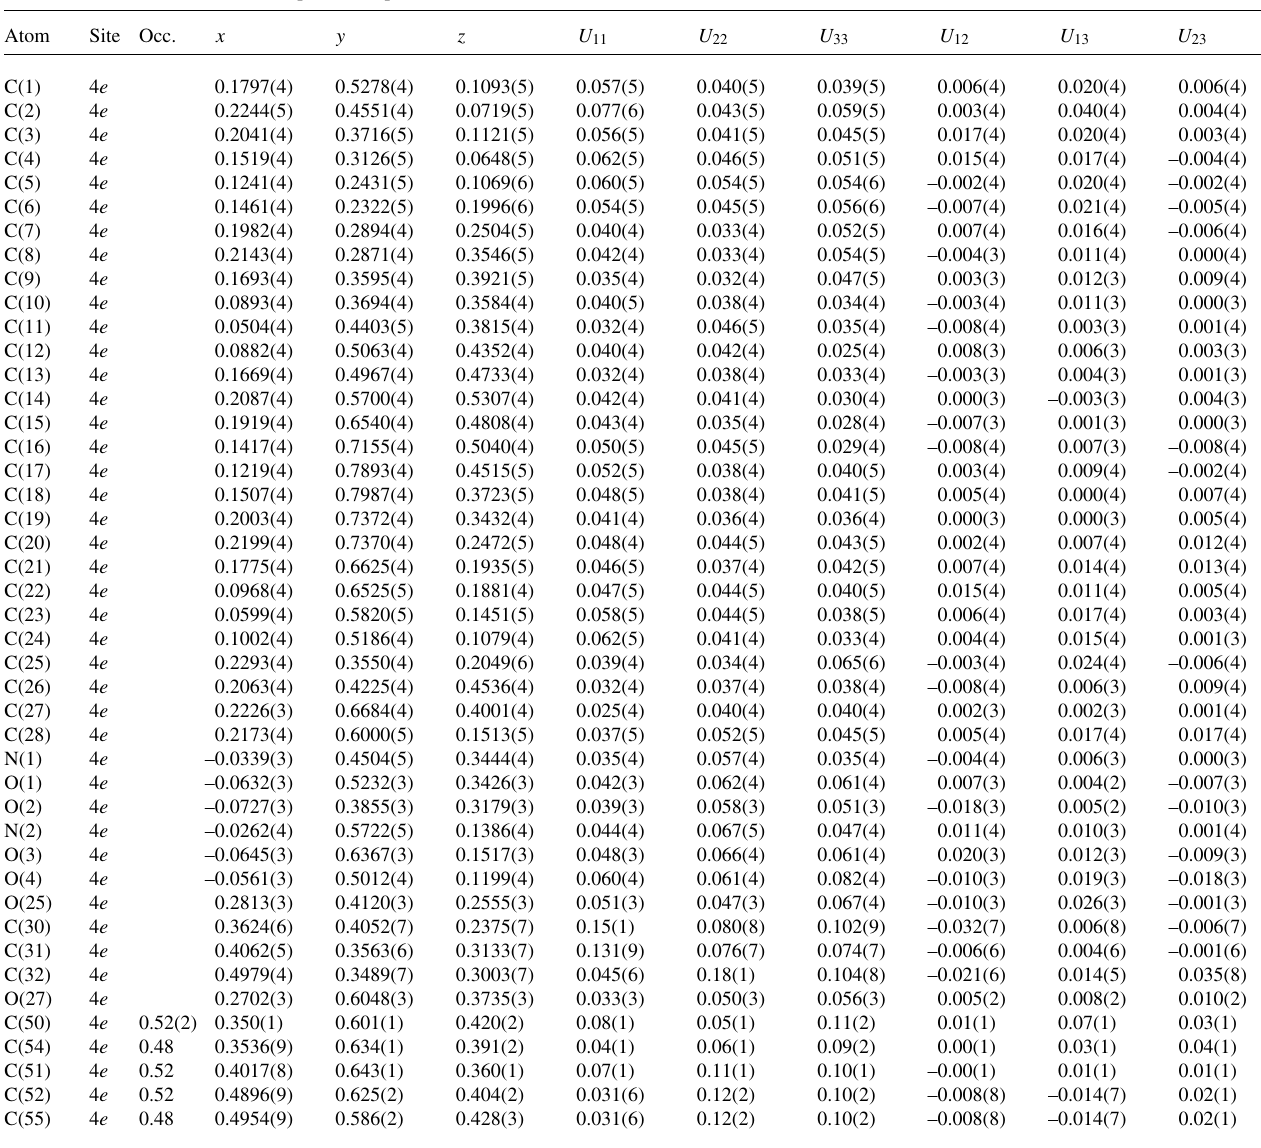
Table 3. Atomic coordinates and displacement parameters (in Å 2 )